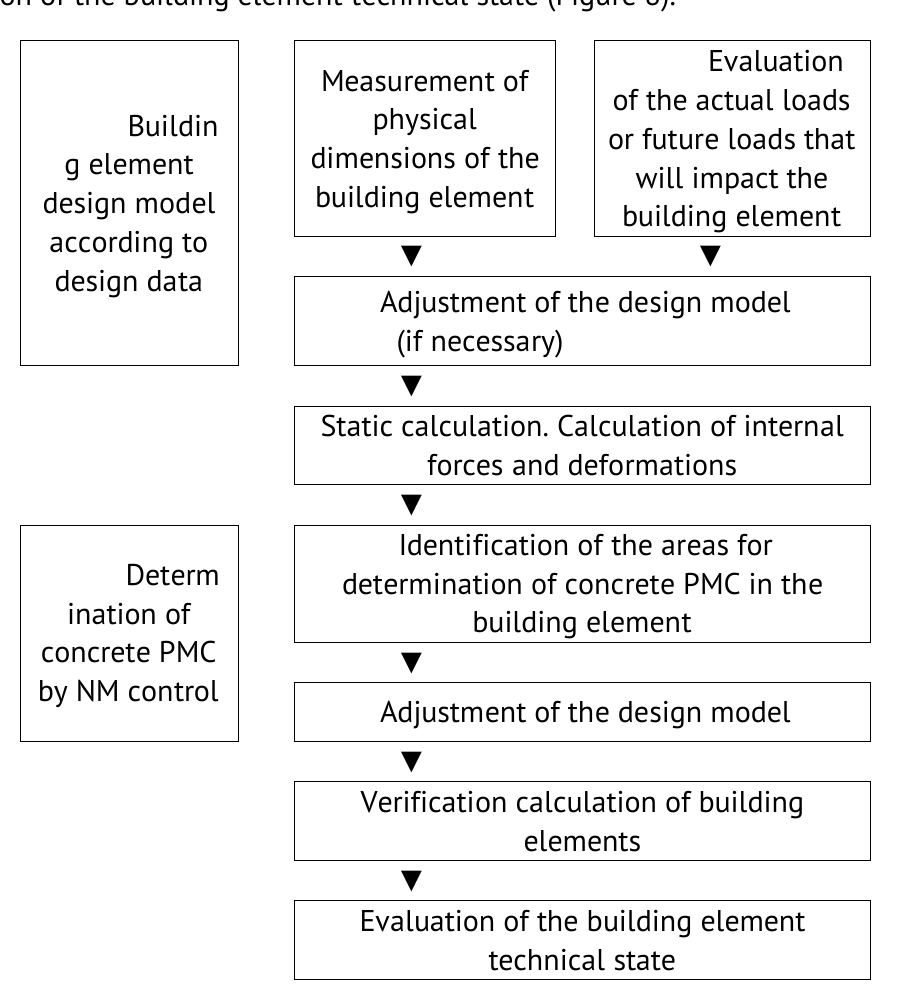
Figure 8. Procedure for evaluation of the building element technical